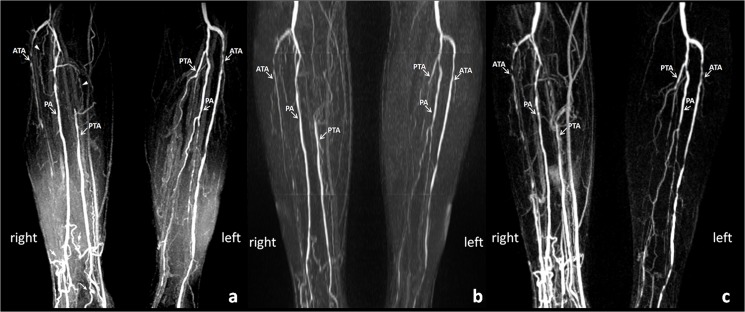
MIP images with different optimal window level of FSD (a), QISS (b), and CE-MRA (c) of the calf arteries demonstrate diffused severe lesions in the left anterior tibia artery (ATA) and occlusions in the right ATA and left posterior tibia artery (PTA) in a 65-year-old man with diabetes and renal insufficiency.Collaterals are seen at the right proximal peroneal artery and PTA (arrow head) as well as the distal calf arteries (arrow). FSD shows better delineation of the arterial lesions and small collaterals compared to QISS. Soft tissue and deep venous contaminations caused by faster deep venous flow appear on the FSD image. But it doesn’t affect the evaluation of arterial lesions because of the high arterial contrast as well as isotropic spatial resolution. MIP: maximum intensity projection; FSD: flow-sensitive dephasing; QISS: quiescent-interval single-shot; CE-MRA: contrast-enhanced MR angiography; PA: peroneal artery (PA).